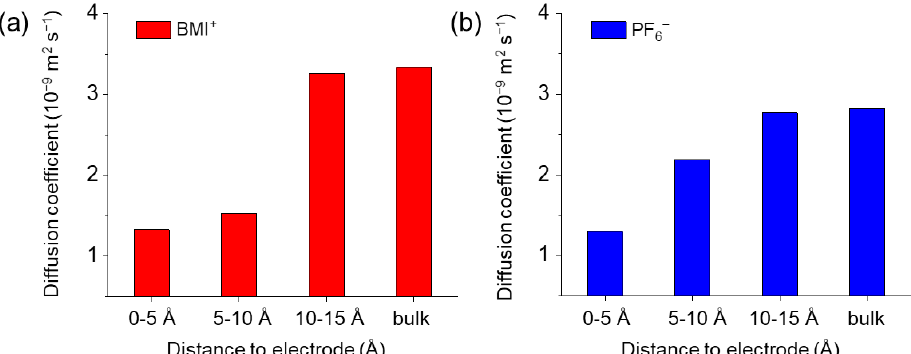
Figure 9. ( a ) Diffusion coefficients of BMI + ions in different EDL regions on the negative MoS 2 electrode. ( b ) Diffusion coefficients of PF 6 − ions in different EDL regions on the positive MoS 2 electrode.